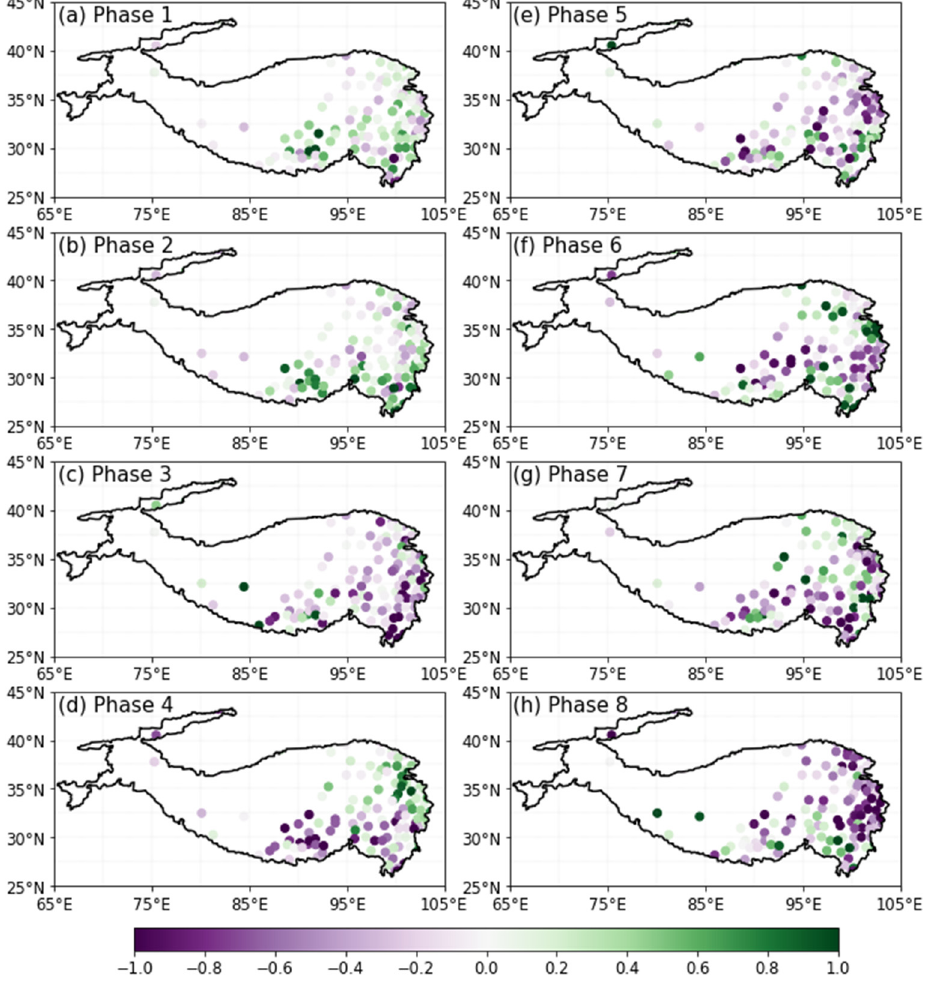
Figure 5. Composites of the station (dots) precipitation anomalies (mm/day) in MJO Phases 1–8 ( a – h ) over TP in boreal summer during 1980–2020.